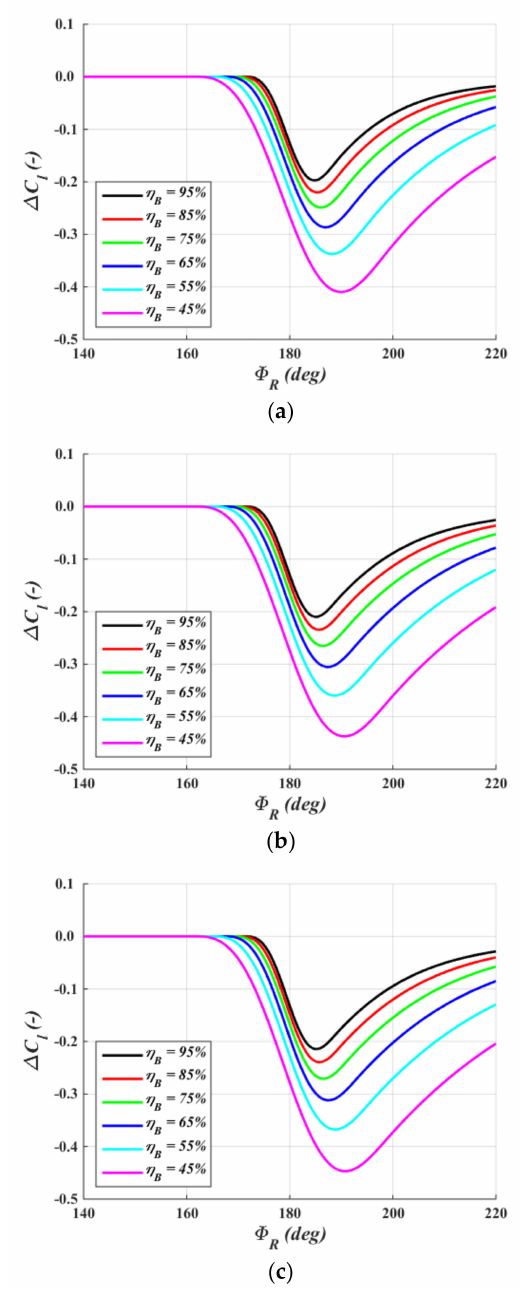
Figure 4. Deviations in wind speed of the rotor plane and the lift coe ffi cient according to the present method with Munduate’s threshold: ( a ) Case 1: V T = 36.0 m / s; ( b ) Case 2: V T = 44.1 m / s; ( c ) Case 3: V T = 46.7 m /